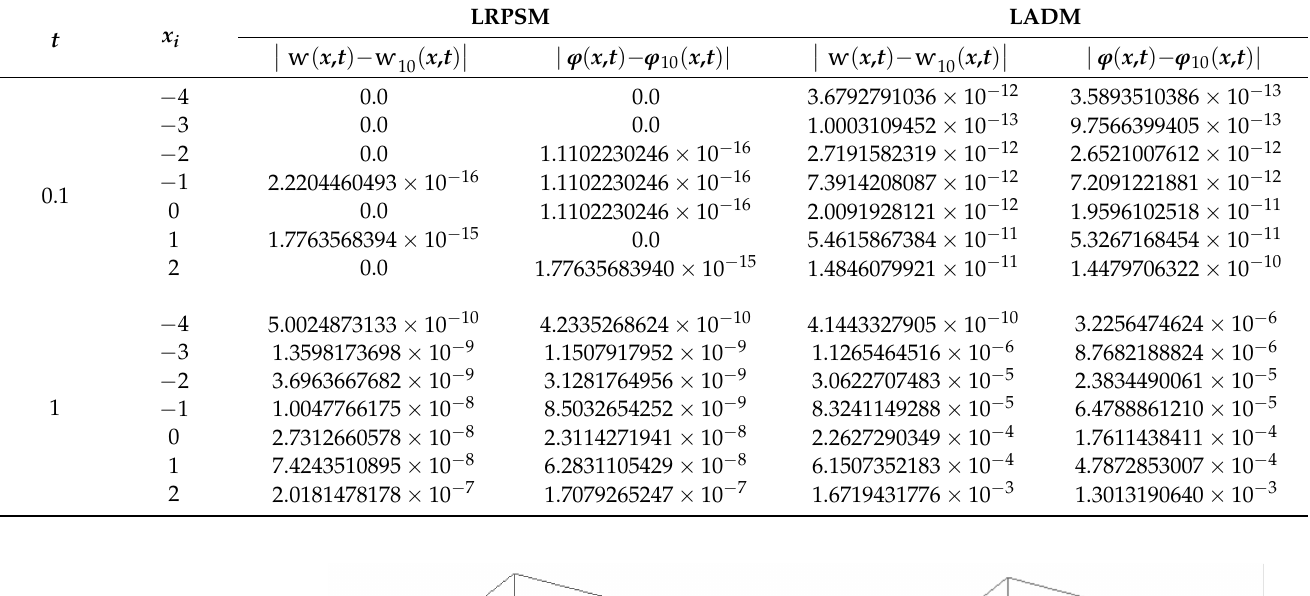
Table 5. Numerical comparisons between the absolute errors for Example 1.